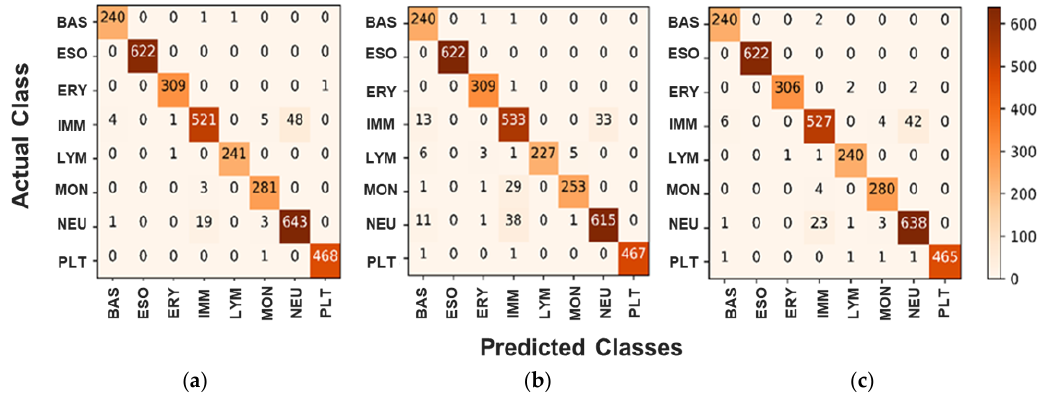
Figure 6. Confusion Matrix for Multiclass scenario for the proposed BCNet with different optimizers. ( a ) ADAM optimizer, ( b ) RMSP optimizer, and ( c ) SGD optimizer.